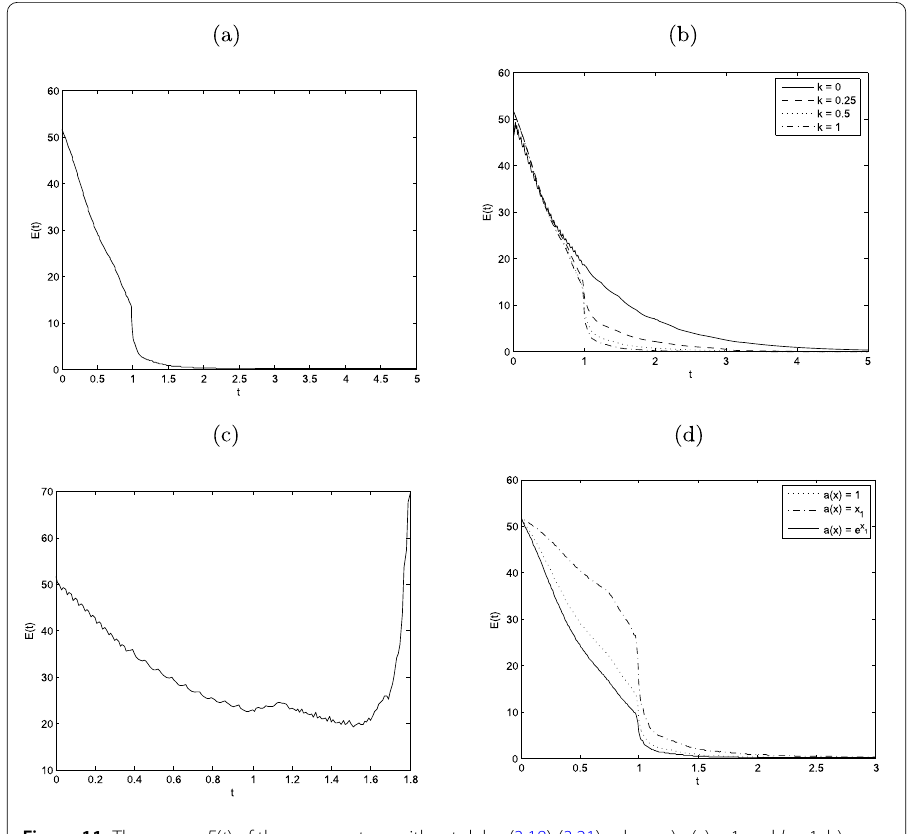
Figure 11 The energy E ( t ) of the wave system without delay (3.18)-(3.21), when: a) a ( x ) = 1 and k = 1; b) a ( x ) = 1, and for k > 0; c) a ( x ) = 1, and k = –0.1; d) k = 1, and for various a ( x )